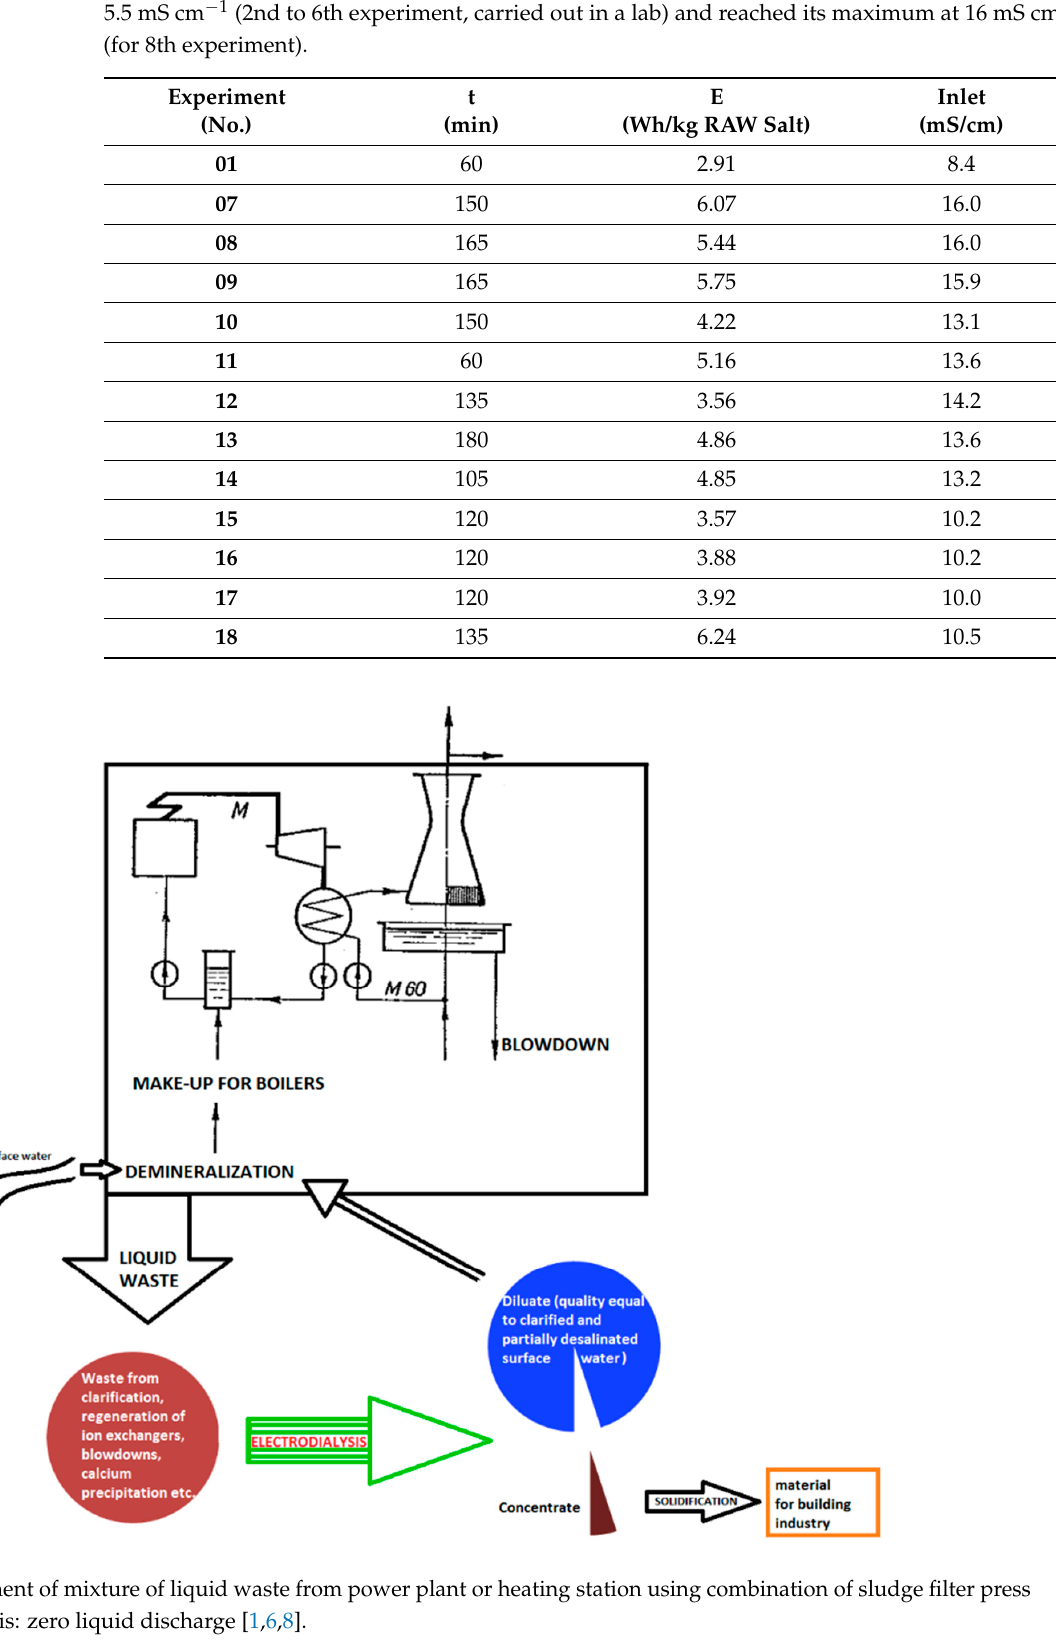
Table 6. Consumption of electric power for each experiment. The inlet waste-water started at 5.5 mS cm − 1 (2nd to 6th experiment, carried out in a lab) and reached its maximum at 16 mS cm − 1